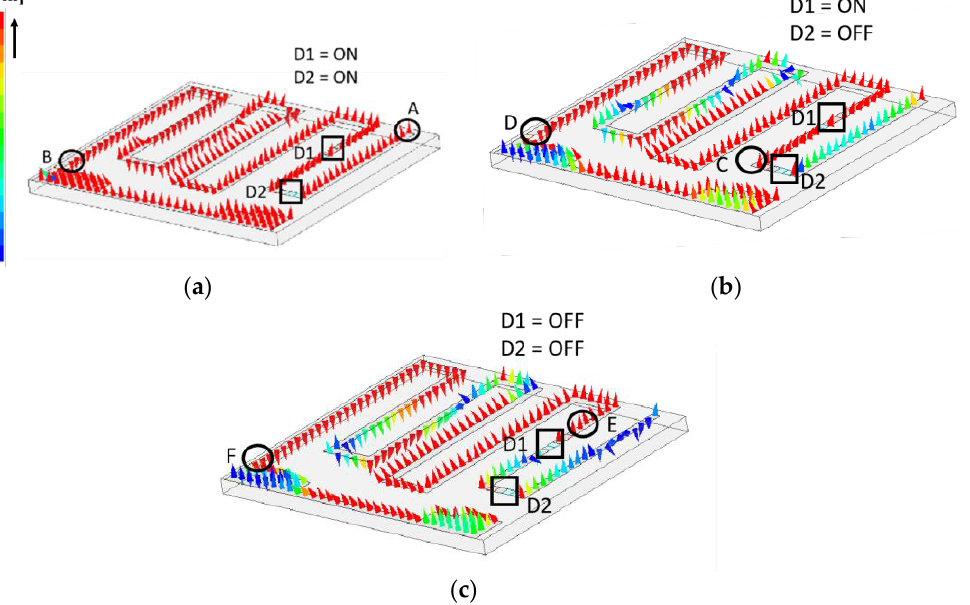
Figure 7. Electric field vector distribution for three different switching conditions: ( a ) 840 MHz; ( b ) 900 MHz; ( c ) 950 MHz .